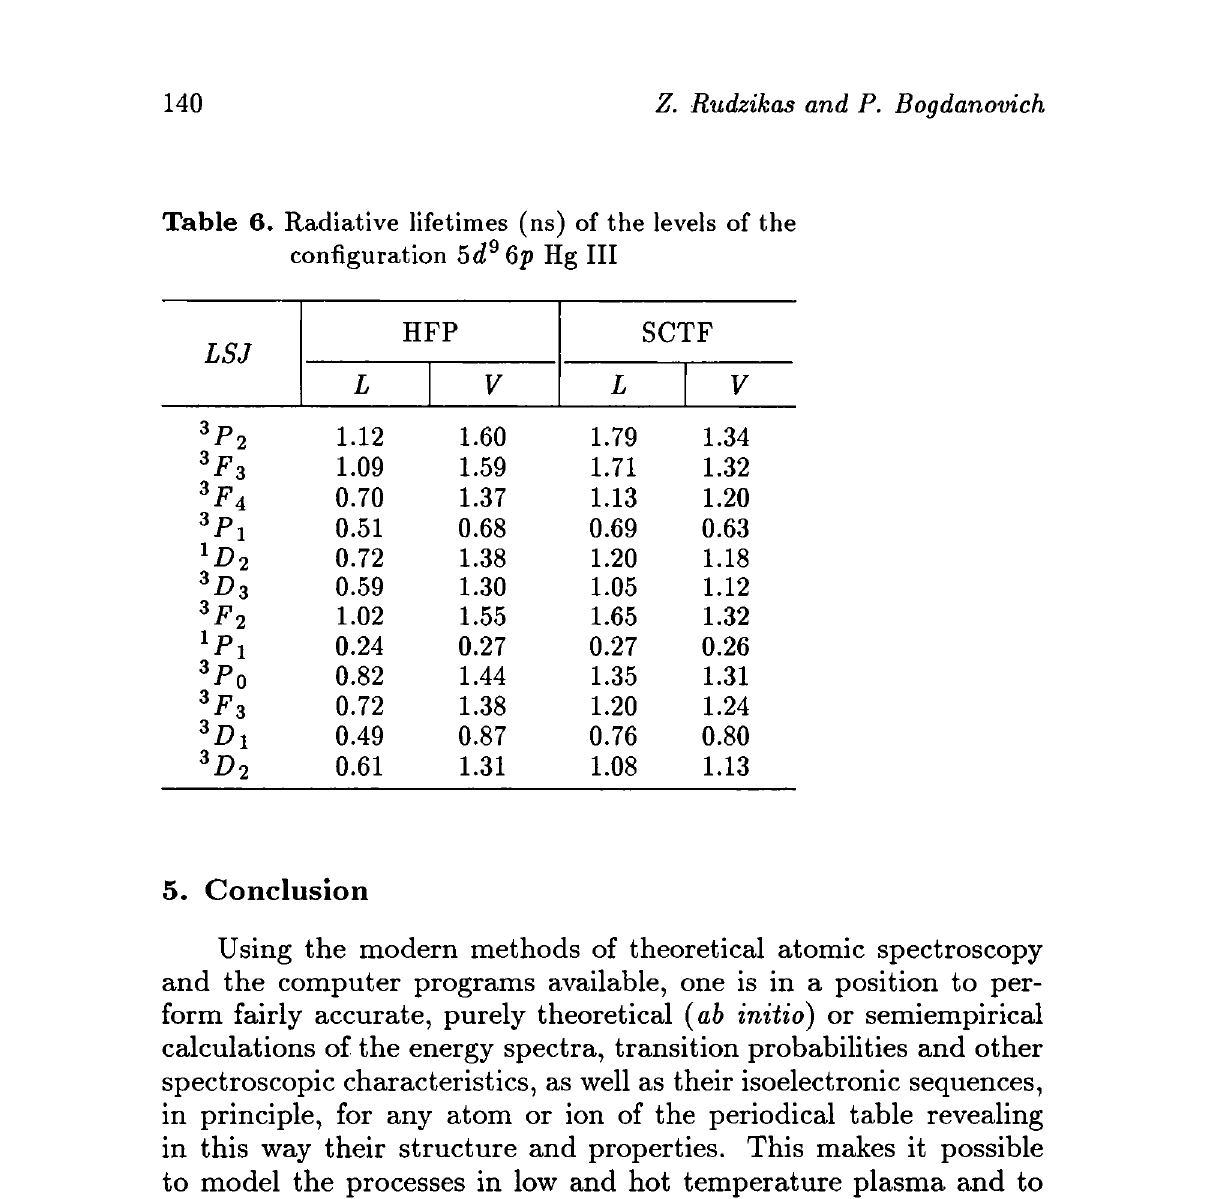
Table 6. Radiative lifetimes (ns) of the levels of the configuration 5d g 6p Hg III